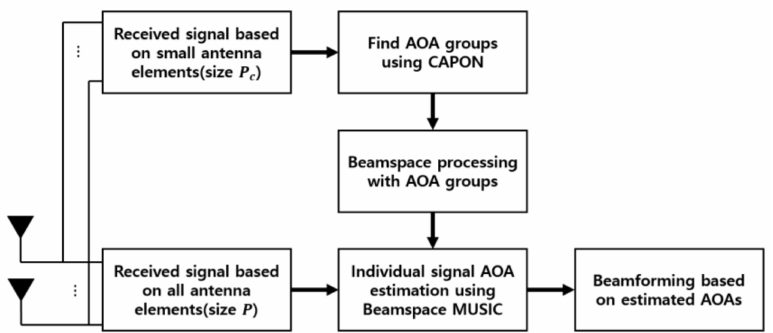
Figure 2. Architecture of cascade Angle-of-Arrival (AOA) estimation algorithm based on flexible (ON / OFF) massive antenna